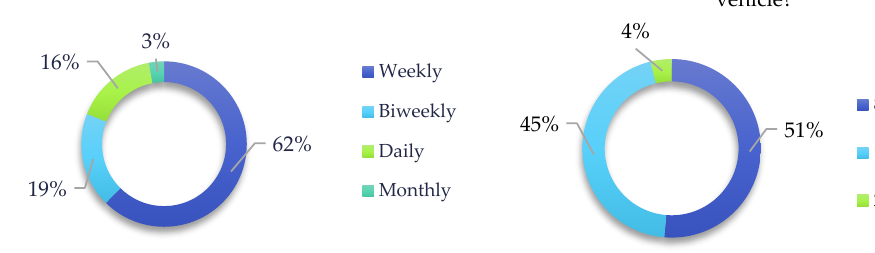
Figure 4. Fuel level for the next recharge. The surveyed population prefers to refuel their vehicle weekly in terms of frequency, hours, refueling time, and monthly budget. From 8:00 am to 10:00 pm, the average time they spend at the fueling station is 5 to 10 min; and the monthly budget allocated by users is from USD 20 to 50, and the detail is indicated in Figures 5 and 6.